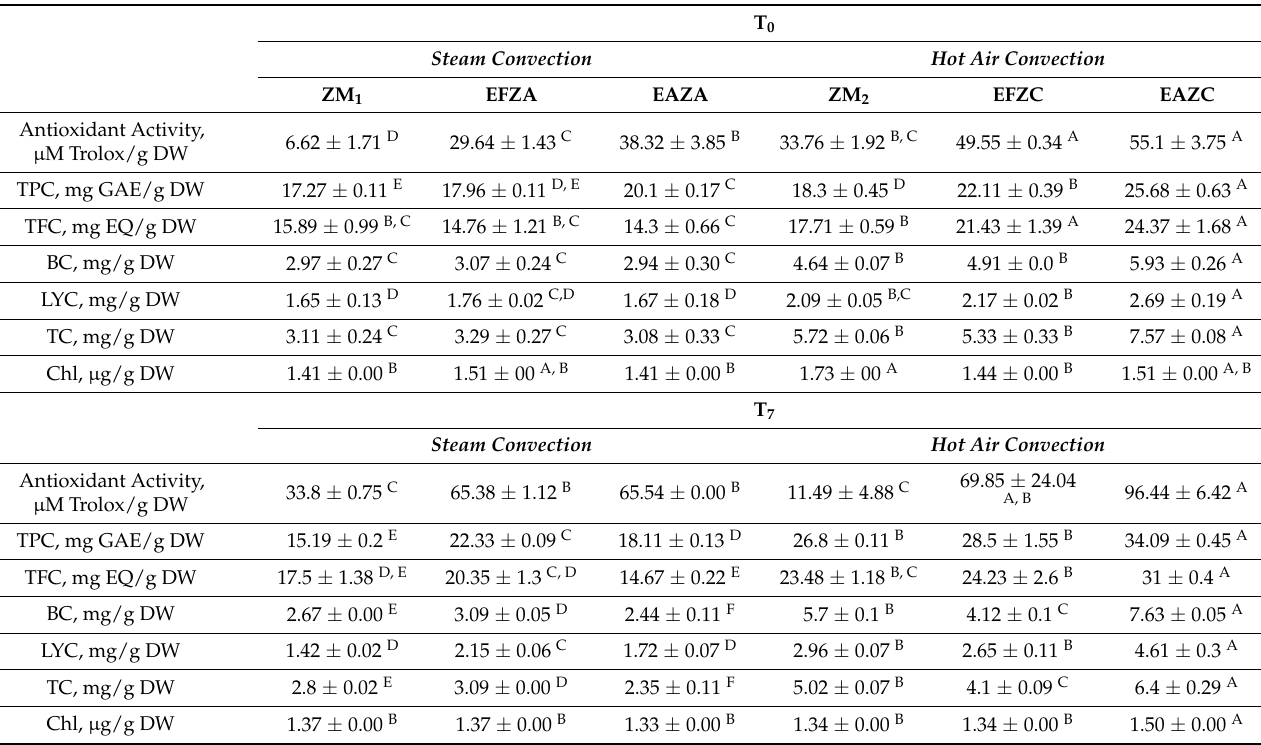
Table 2. Phytochemical content of zucchini purees enriched with fennel or anise aqueous extract, processed by steam or hot air convection, just after treatment and after one week of